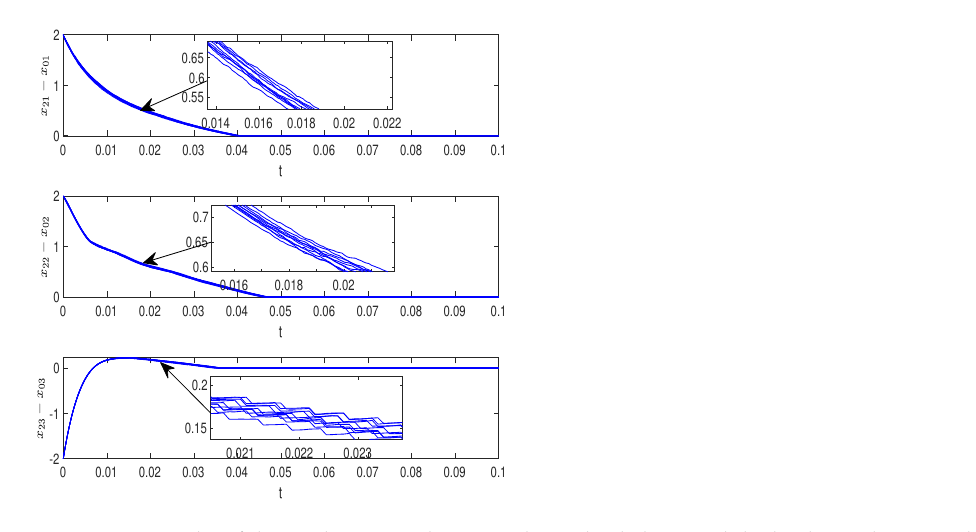
Figure 3. Ten paths of the tracking error between the 2nd subchain and the leader with protocol (6). Fig.3. 10 paths of the tracking error between the 2-th subchain and the leader with protocol (4.2).